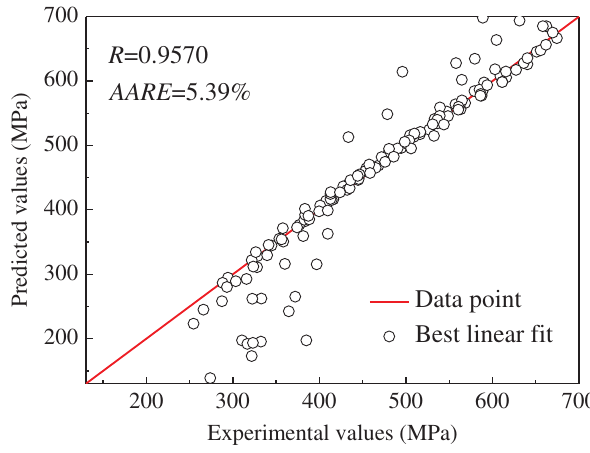
Figure 19: The correlation relationships between the predicted and experimental true stress for the modified constitutive at low tem- perature